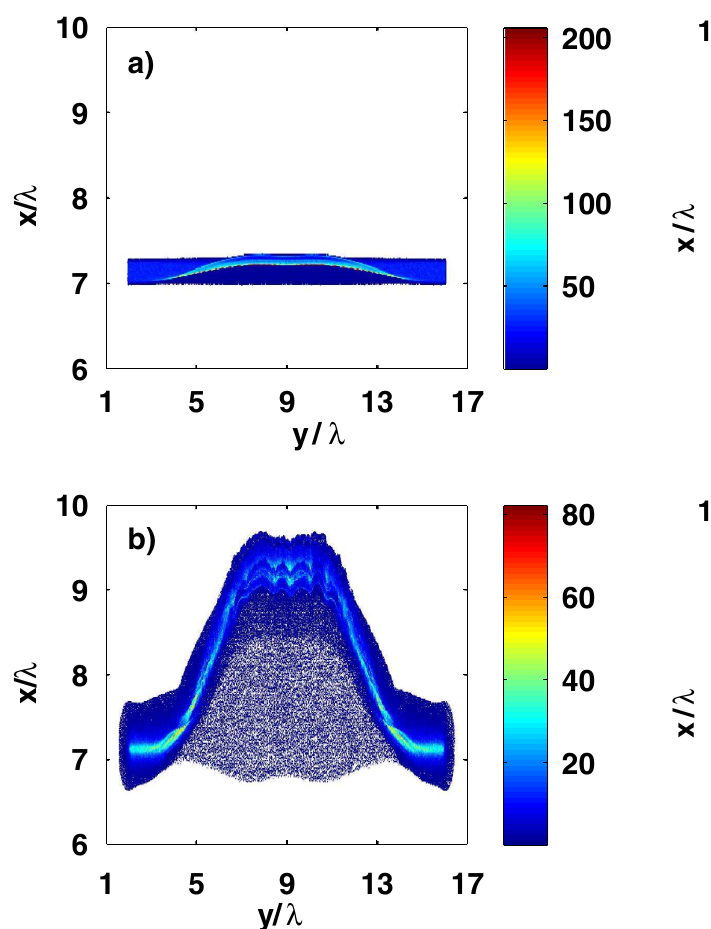
FIG. 8. (Color) Spatial ion density profile in the 2D3V PIC simulation in the interaction time 8 (cid:2) (a) and 28 (cid:2) (b). In the interaction time 28 (cid:2) a hole bored in the central part of the foil can be observed. The simulation parameters are the same as in Fig. 3 with the radial intensity profile of the laser pulse shown in Fig. 7. The ion density is normalized to the critical density and the spatial coordinates are normalized to the laser wavelength. The midpoint of the simulation box is at 9 (cid:1) and the laser pulse is incident from the